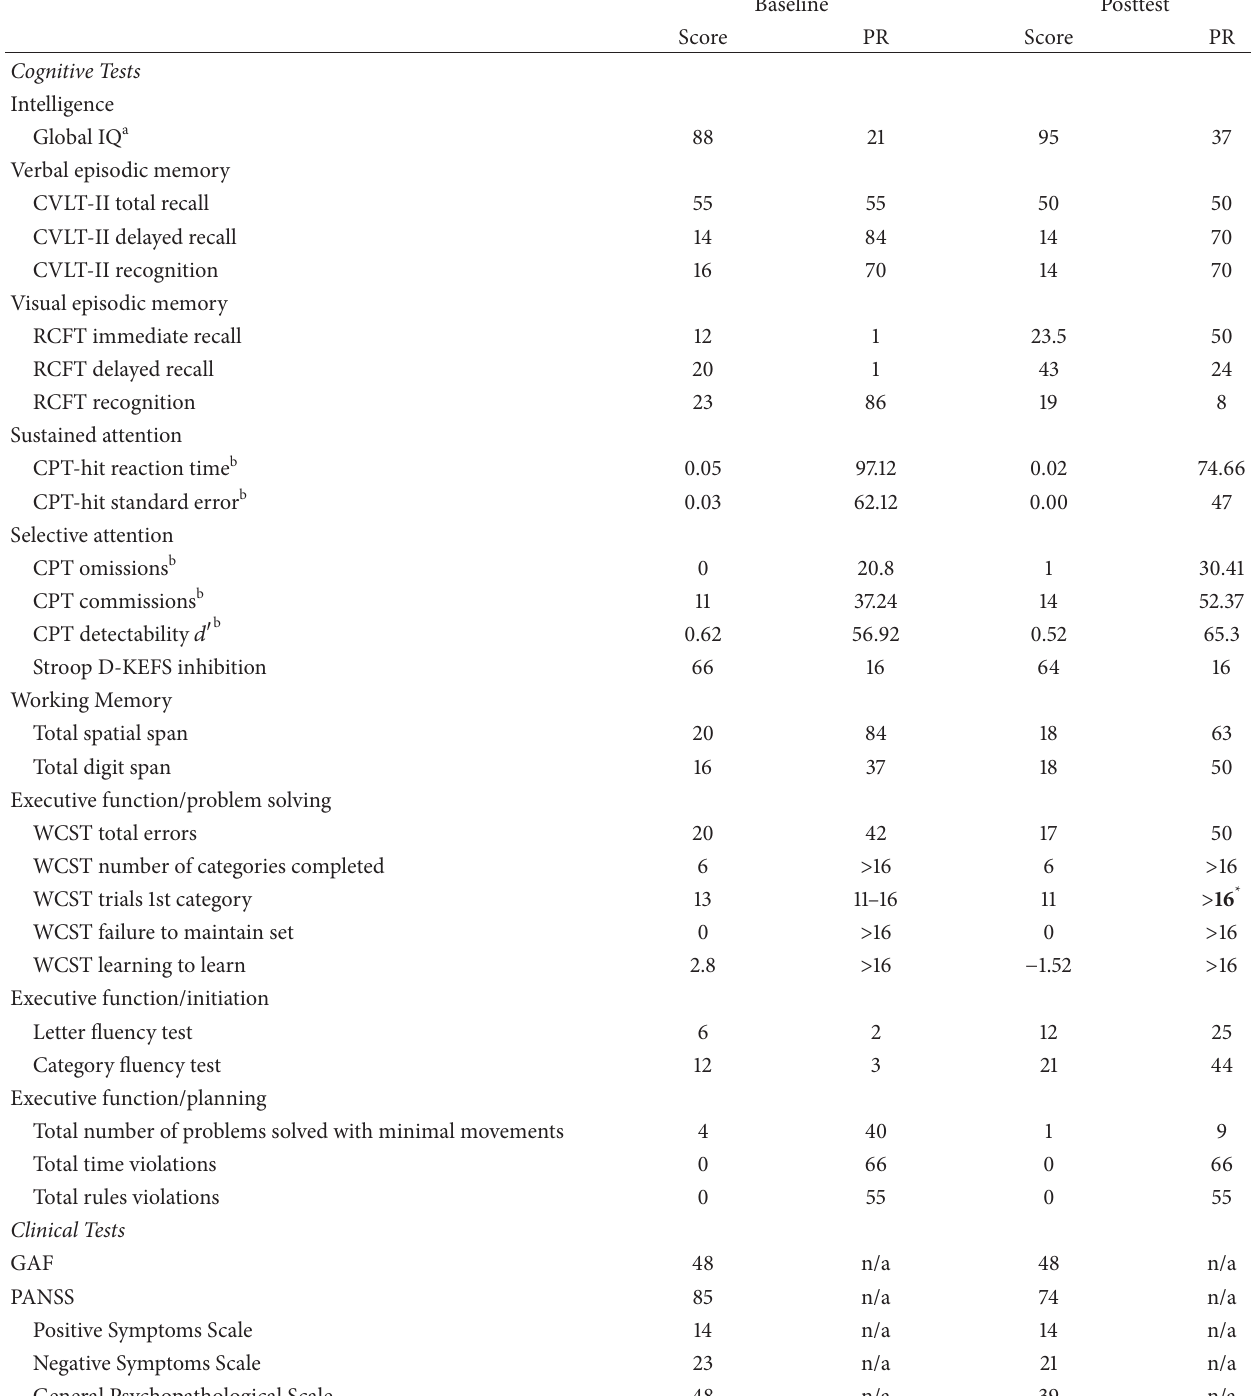
Table 2: Case A’s results on neuropsychological and clinical